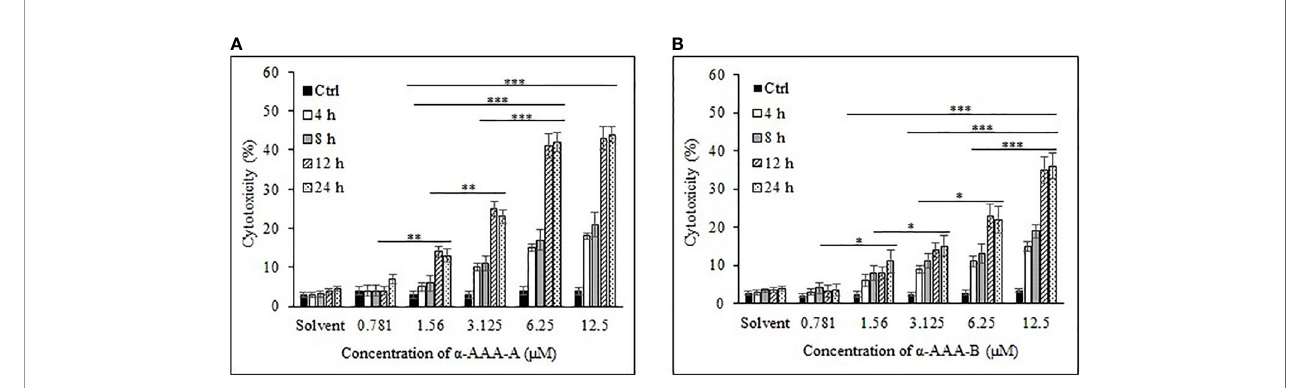
FIGURE 3 | Cancer cell line K562 cytotoxicity by a -AAA-A (A) and a -AAA-B (B) at different concentrations and time durations of incubations. *** P <0.001, on comparing cytotoxicity by a -AAA-A at 12.5, 6.25 and 3.125 m M with 1.56 m M after 12 and 24 h of incubations. *** P <0.001, on comparing cytotoxicity by a -AAA-B at 12.5 with 6.25 m M; 12.5 with 3.125 m M; 12.5 with 1.56 m M after 12 and 24 h of incubations. ** P <0.01, on comparing cytotoxicity by a -AAA-A at 3.125 with 1.56 m M; 1.56 with 0.781 m M. * P <0.05, on comparing cytotoxicity by a -AAA-B at 6.25 with 3.125 m M; 3.125 with 1.56 m M; 1.56 with 0.781